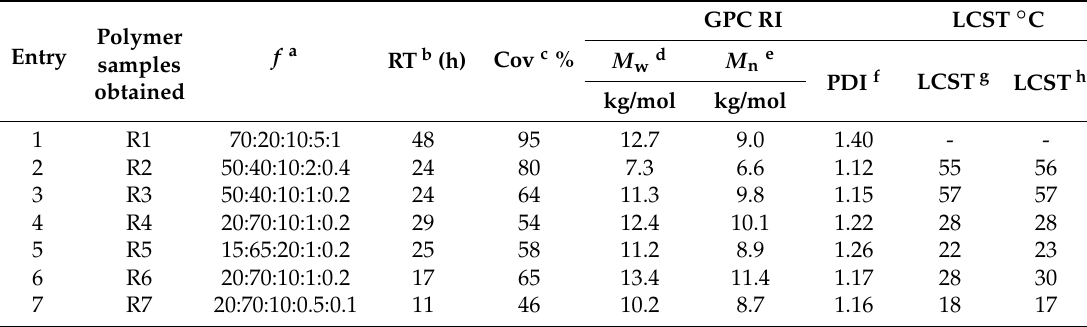
Scheme 1. Synthesis of reducible thermoresponsive hyperbranched polymers with multivinyl functionality via reversible addition-fragmentation chain transfer (RAFT) copolymerisation of poly(ethylene glycol)methyl ether methacrylate (PEGMEMA), poly(propylene glycol)methacrylate (PPGMA), and disulfide diacrylate (DSDA). Table 1. Synthesis of reducible and thermoresponsive polymers from RAFT copolymerisations of PEGMEMA, PPGMA, and DSDA at 65 °C in n -butanone.